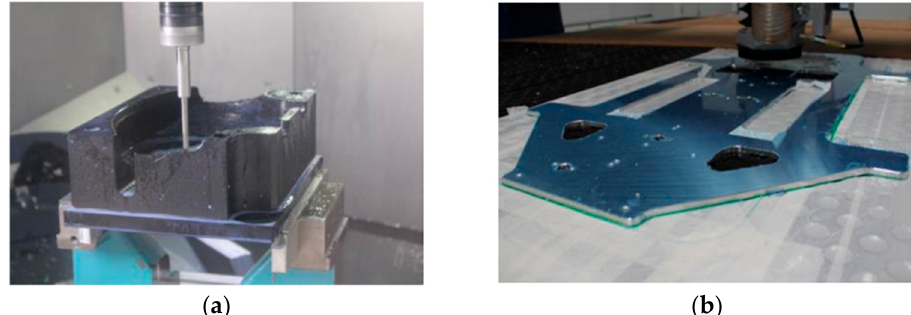
Figure 2. The part being machined in an M1 milling machine ( a ), and an M4 milling machine ( b ). The developed tool’s working principle is shown in Figure 3.